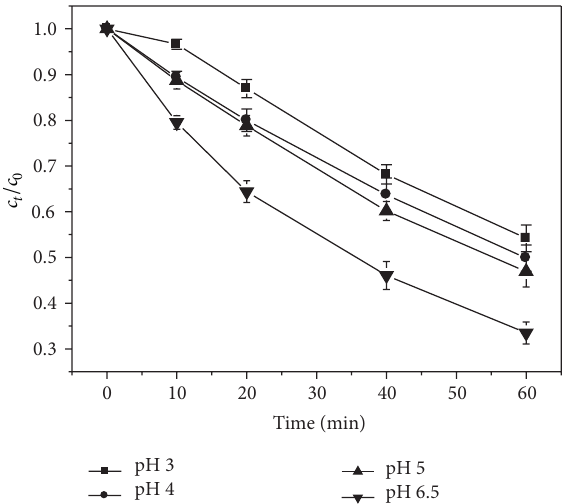
Figure 5: Effect of pH on the degradation of fuchsin basic (initial dye concentration = 10 𝜇 molL −1 , ultrasonic power = 400W, ultra- sonic frequency = 25kHz, and tempetature = 22 ∘ C).